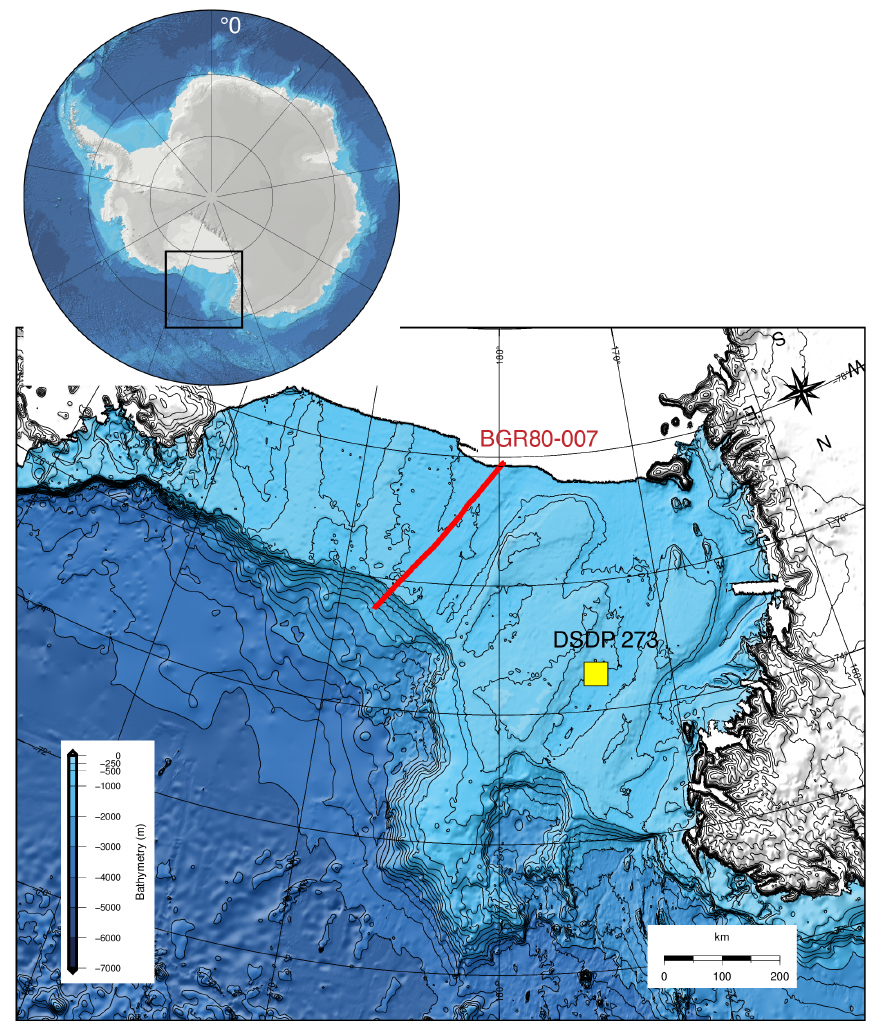
Figure 5. Close-up of the Ross Sea bathymetry from IBCSO (Arndt et al., 2013) and its location in Antarctica. Most of the ice-free bathymetry is backtracked as shown in the case studies below. The BGR80-007 2D marine seismic transect used for validation is indicated with a red line, and the Deep Sea Drilling Project (DSDP) 273 site location, backtracked in the case studies below, is indicated with a yellow